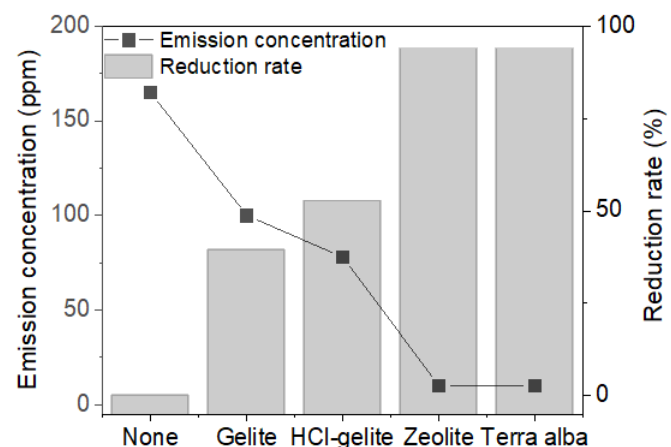
Figure 6. Relative ammonia reduction rate and emission concentration of the foams over-coated by the